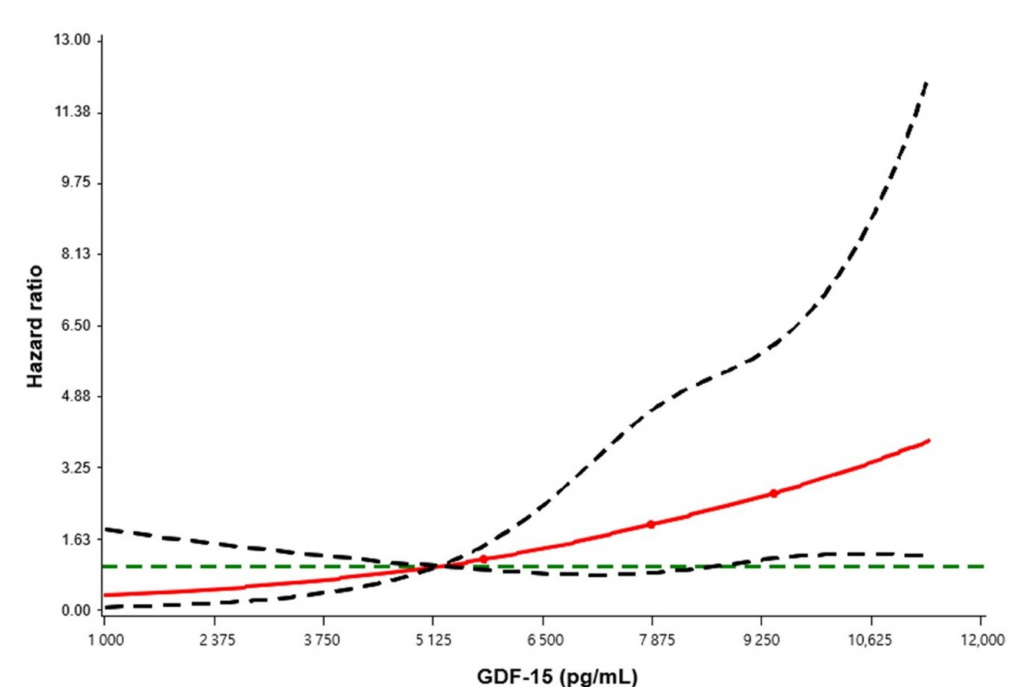
Figure 2. Association between GDF-15 concentration and in-hospital mortality hazard ratio by restricted cubic spline regression model. The reference value is the median of the first tertile (5187.3 pg/mL). The red line indicates the estimated hazard ratio; the dashed green line indicates the reference line of null hypothesis that the hazard ratio is 1; the dashed black lines indicate the lower and upper 95% confidence limits. Abbreviation: GDF-15, growth differentiation factor-15.